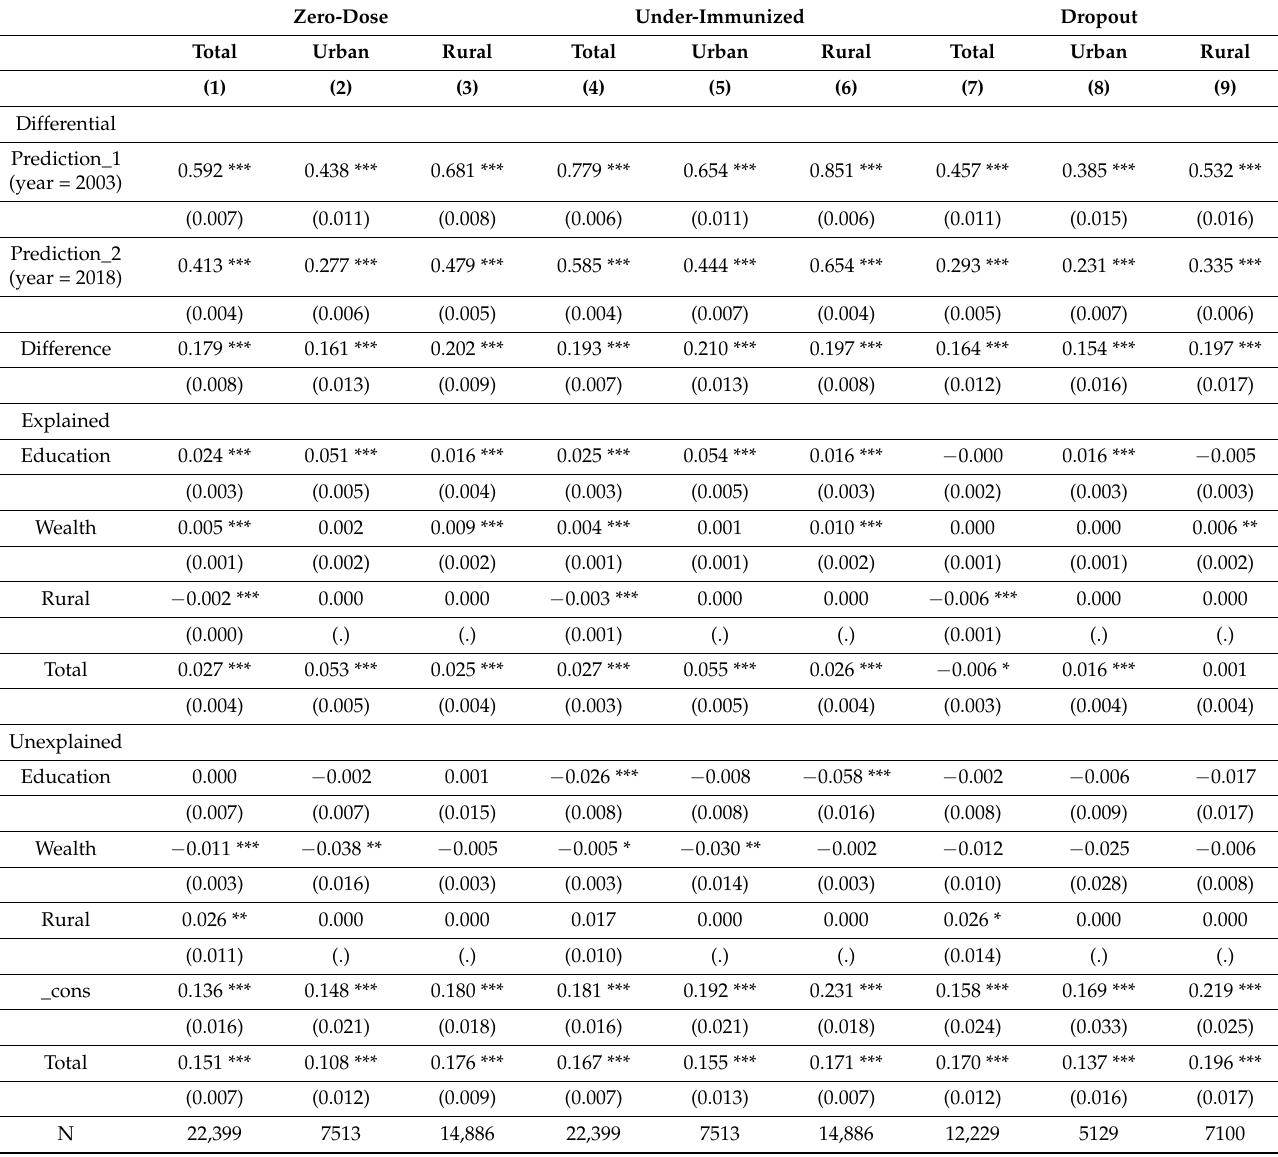
Table 2. Blinder–Oaxaca Decomposition Analysis of the reduction in the number of the children with incomplete vaccination status. Zero-Dose